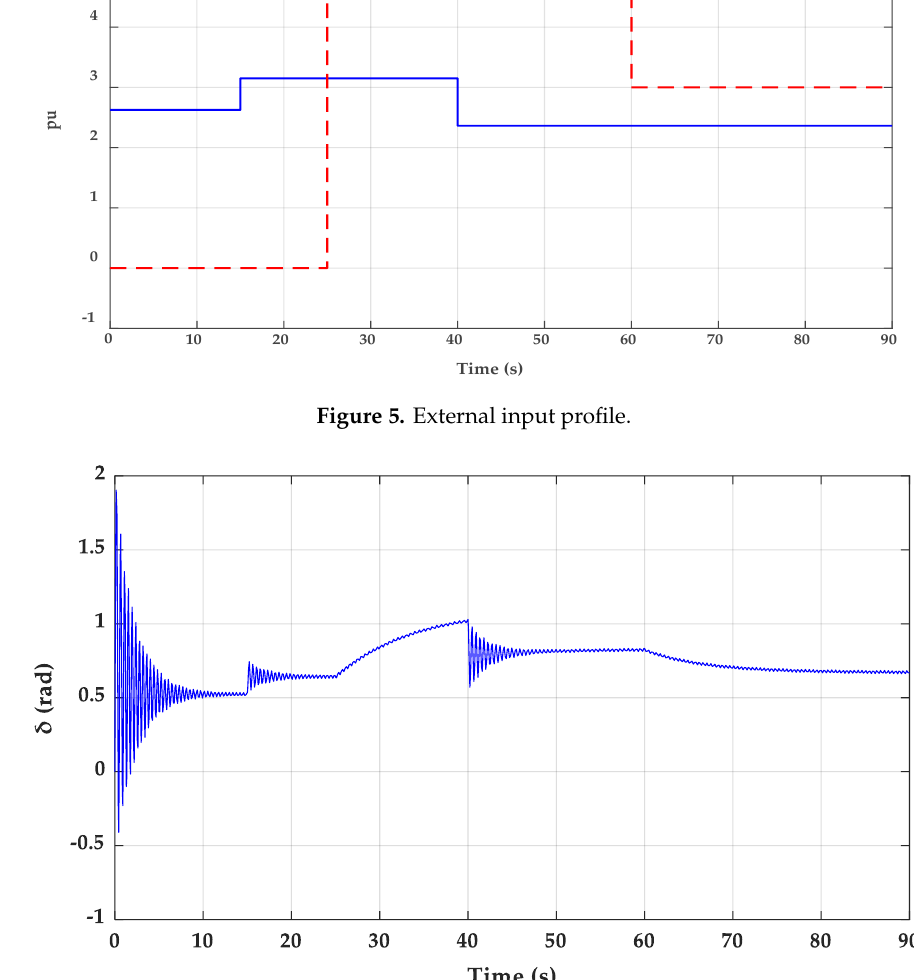
Figure 6. Angle response of the SGIB with reheating.